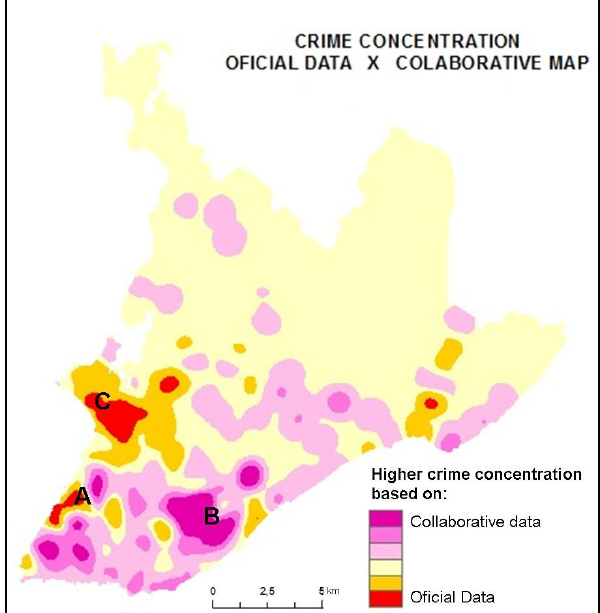
Figure 6. Map of the main differences between areas of concentrated crime indicated by official data (SSP/BA) and collaborative information (“Onde Fui